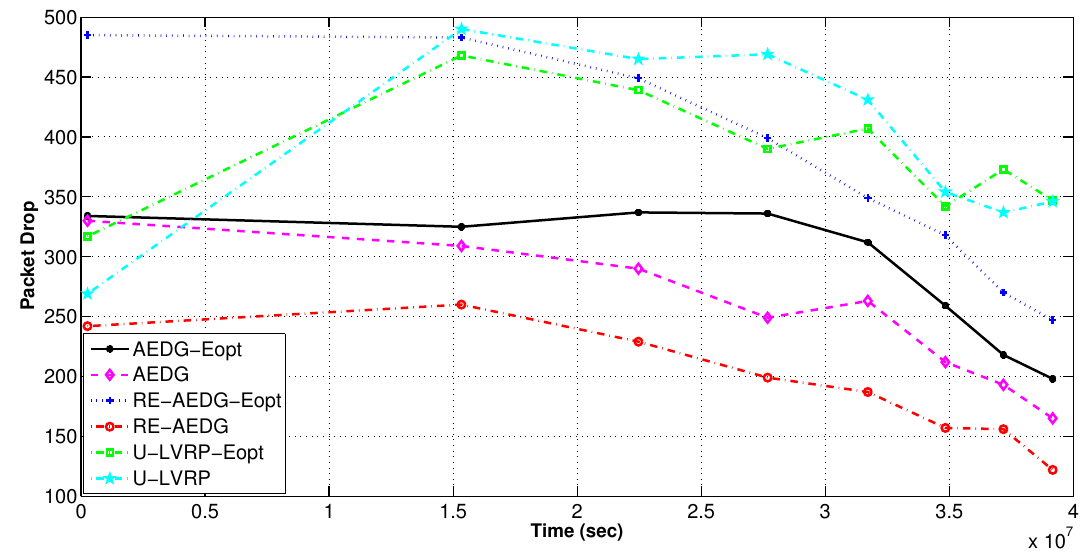
Figure 15. Packets drop rate in energy optimized and non optimized